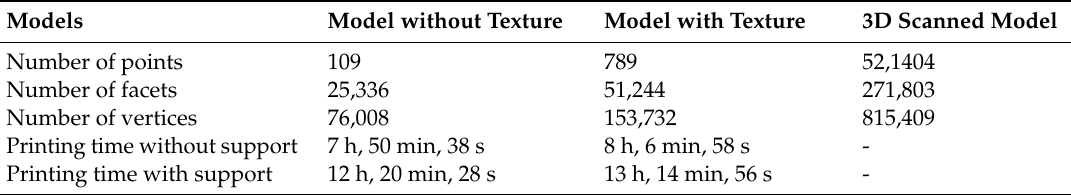
Table 2. Summary of results for di ff erent